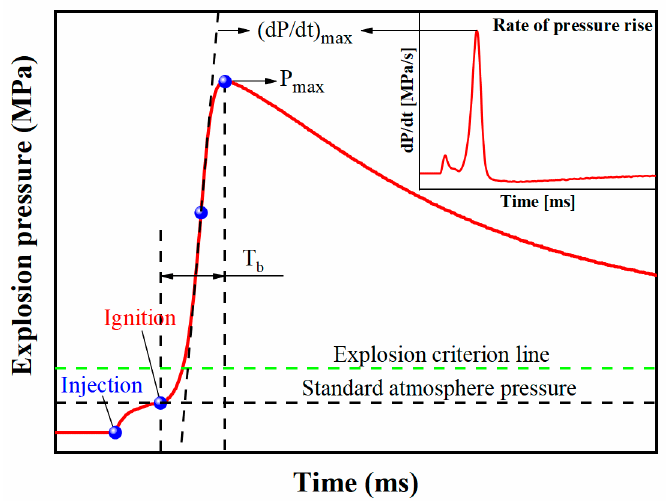
Figure 9. Typical explosion pressure time history.